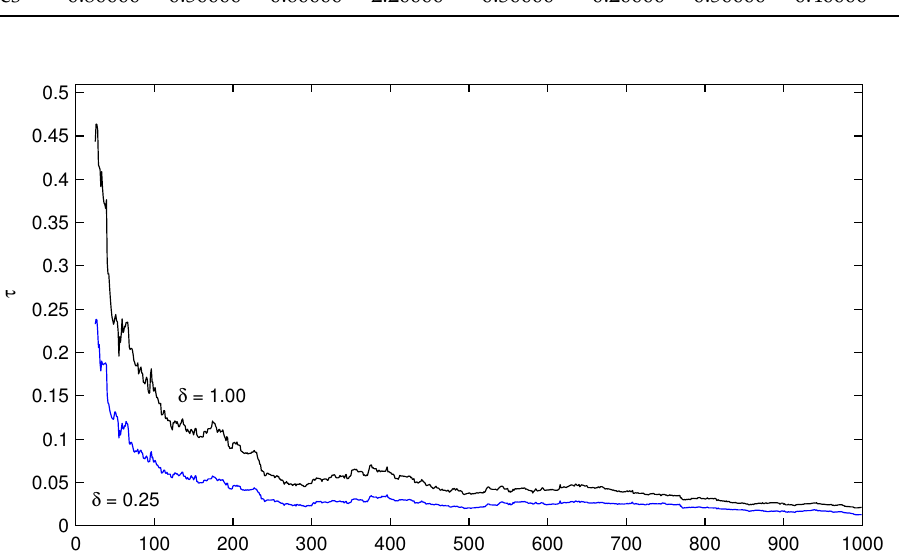
Figure 6. The estimation errors τ versus k with different noise variances for Example